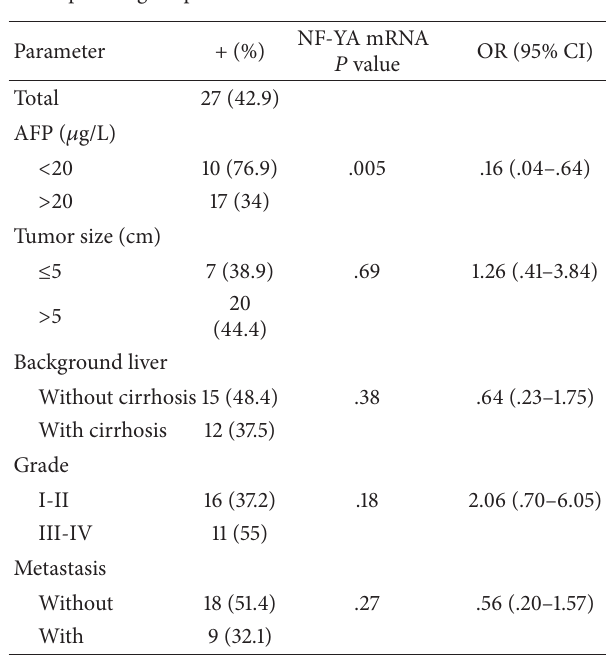
Table 3: Relationship between NF-YA mRNA expression and clinicopathological parameters in HCC tissues.